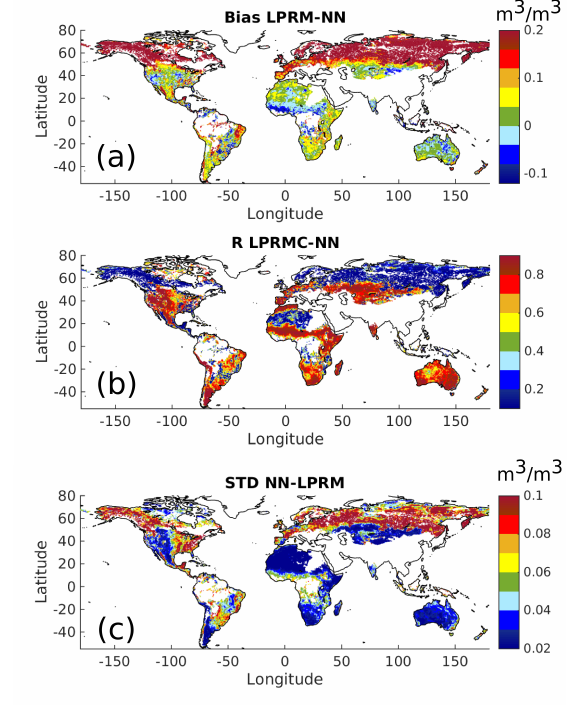
Figure 7. Comparison of AMSR-E NN SM and AMSR-E LPRM (applied to the C-band) from January 2003–October 2011. ( a ) Bias (mean of Land Parameter Retrieval Model (LPRM) SM minus the mean of NN SM); ( b ) Pearson correlation; ( c ) standard deviation of the difference of both